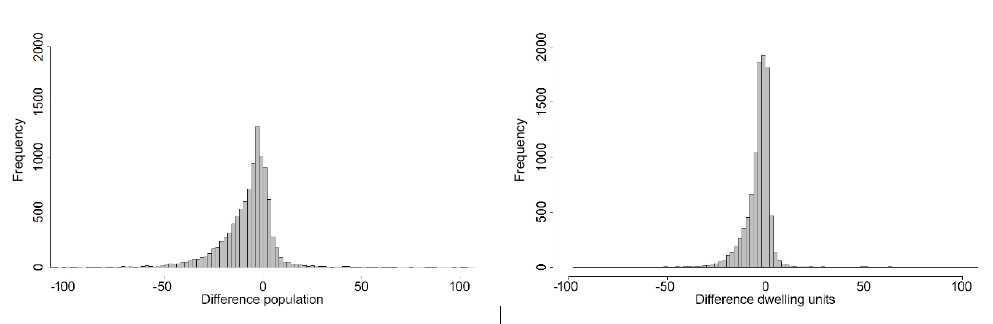
Figure 7. Derived urban structure type at the level of 100 m grid cells.